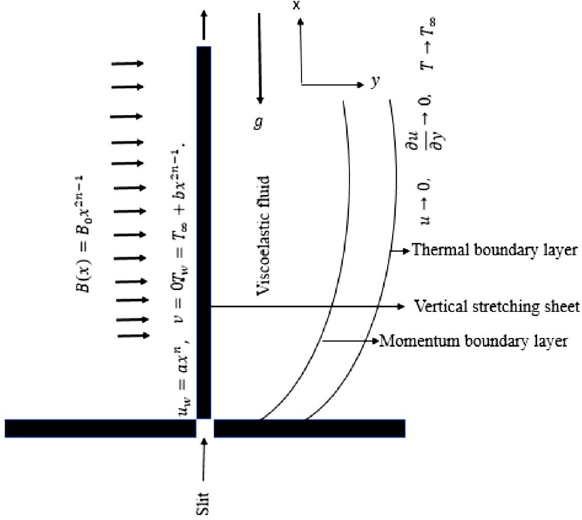
Figure 1. Schematic figure of a stretching sheet in viscoelastic